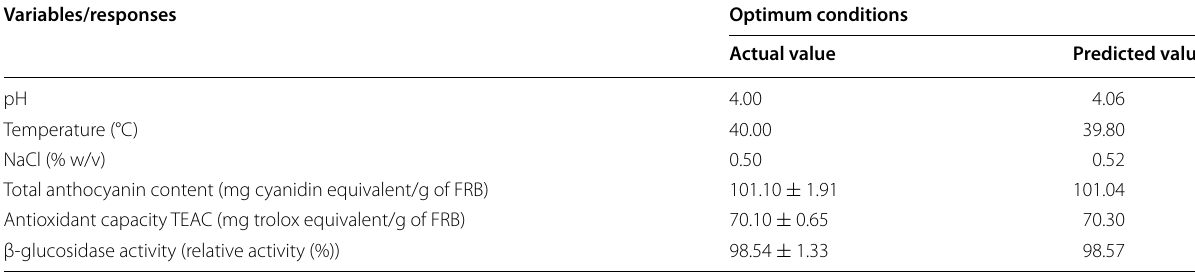
The desirability value of optimum condition was